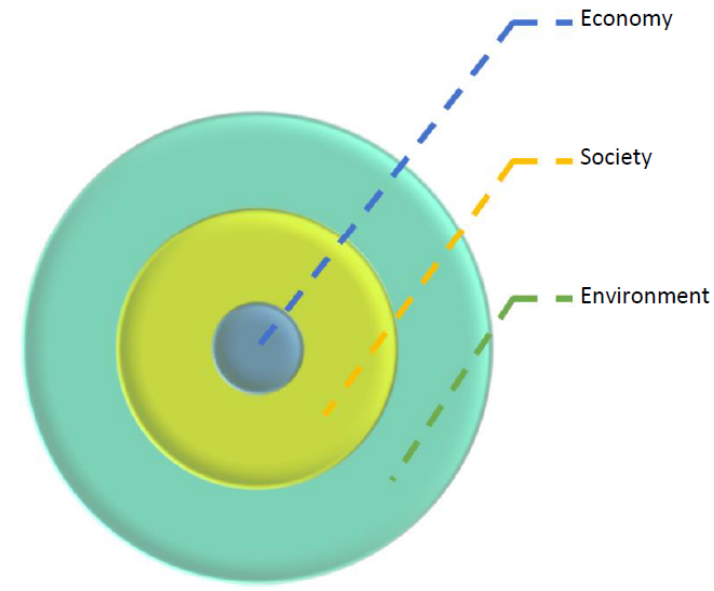
Figure 3. Concentric circles model of sustainability [20].